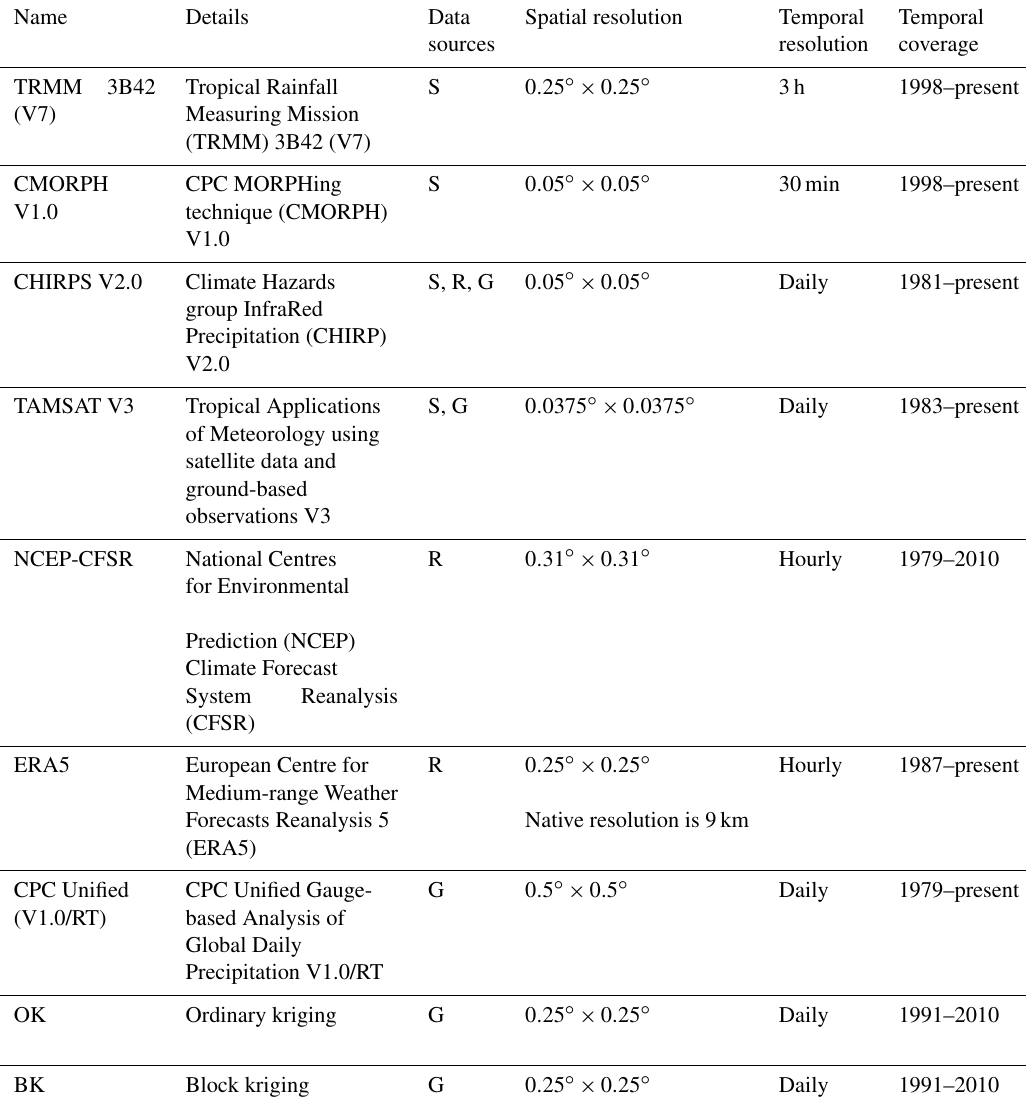
Table 1. Summary of the nine datasets used in this study. The abbreviations in the data sources column are defined as follows: S signifies satellite, R signifies reanalysis, and G signifies rain